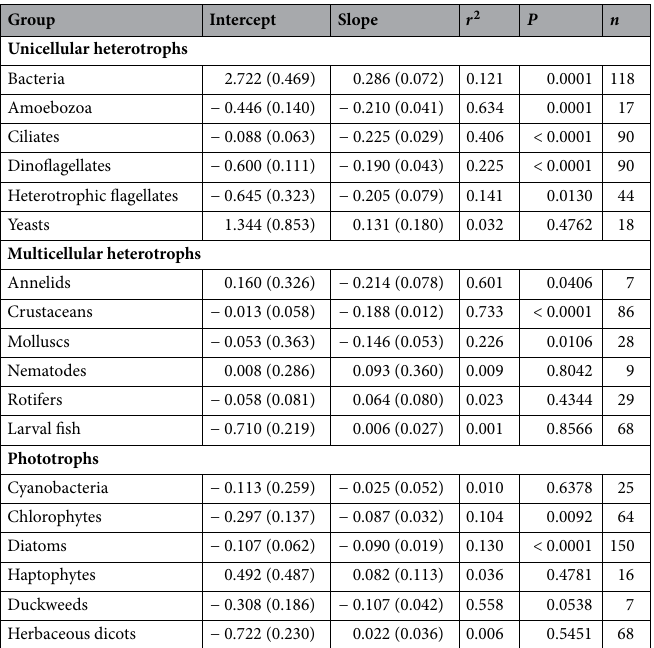
Table 1. Estimates of the intercepts and slopes of least-squares regressions involving log 10 transformations of g max and adult dry mass, in units of days − 1 and μg, respectively. Standard errors are in parentheses. Results are given only for phylogenetic groups where the number of species with available data exceeds five. The heterotrophic flagellate grouping is exclusive of